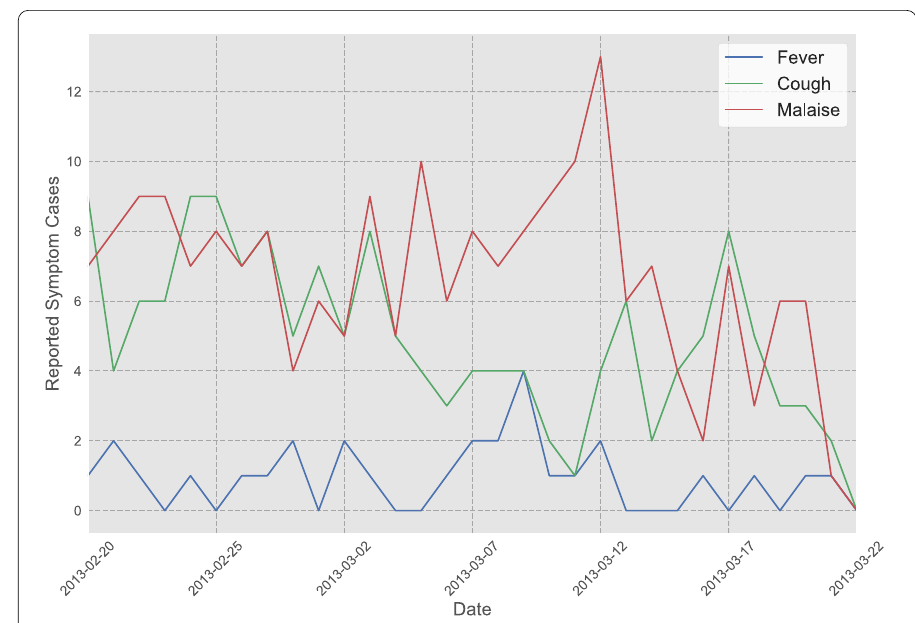
Figure 1 Number of daily reported cases of fever, cough and malaise.